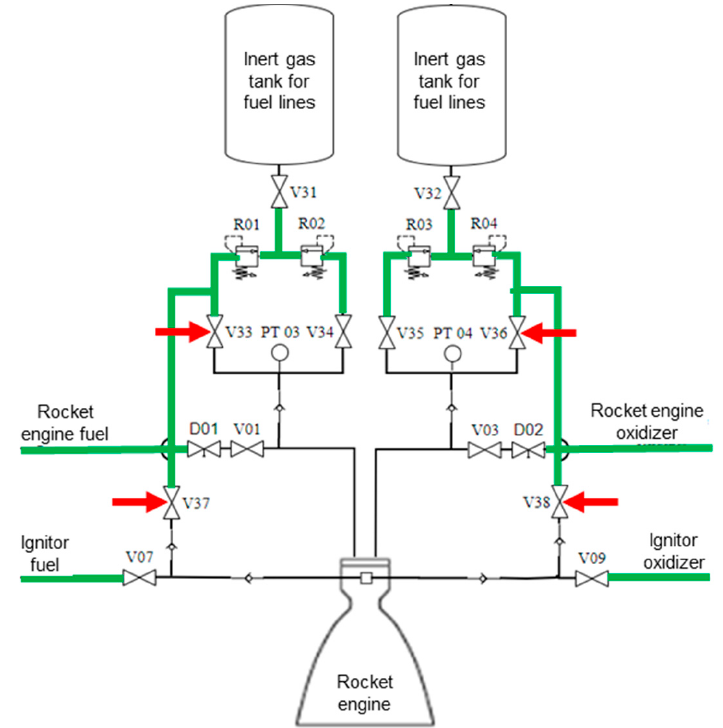
Figure 27. Algorithm’s 10th step diagram.